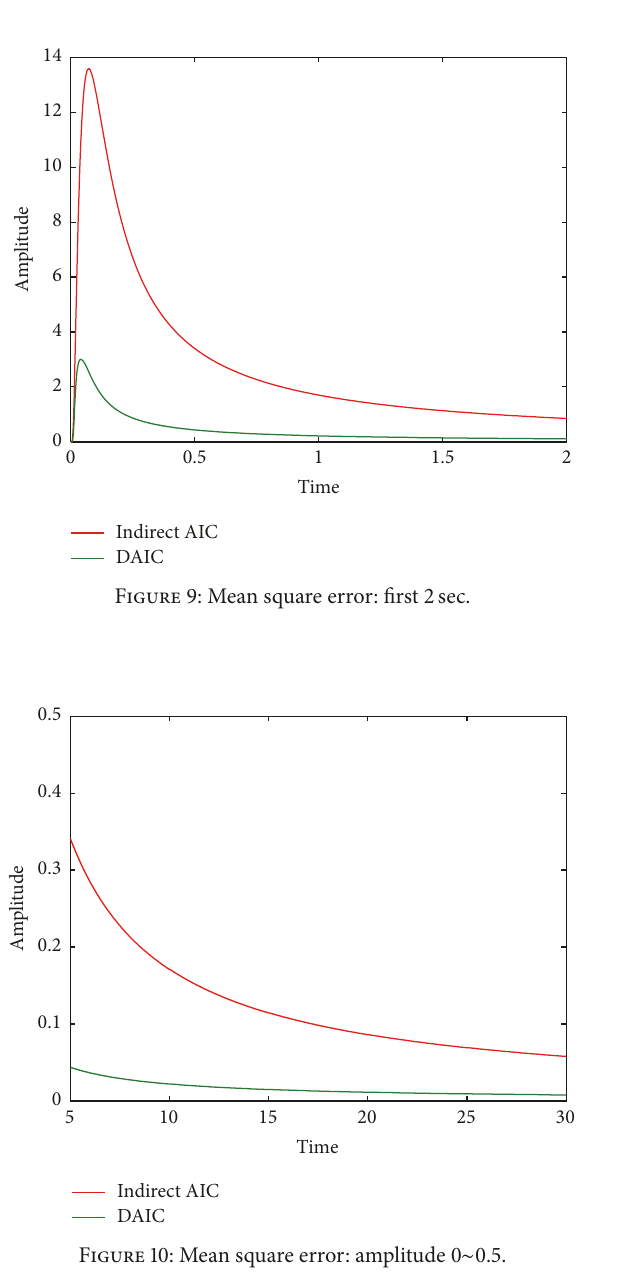
Figure 10: Mean square error: amplitude 0 ∼ 0.5.